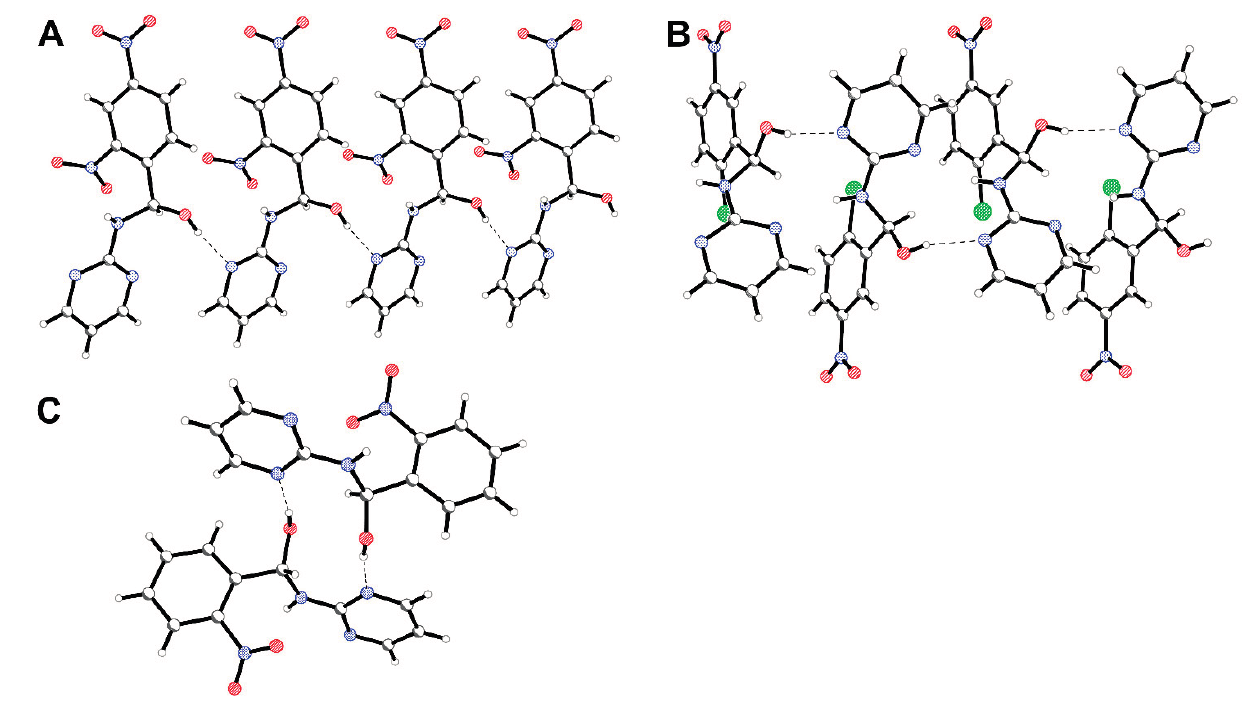
Figure 3. Hydrogen O-H···N1 pyrimidine type bonding schemes in the crystal structures of hemiaminals, ( A ) an infinite chain of the same enantiomers, ( B ) an infinite chains of the opposite enantiomers, ( C )